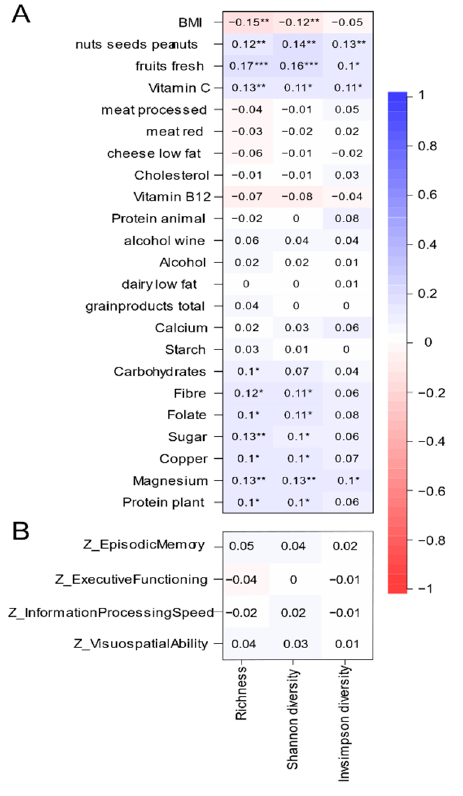
Figure 3. Correlation of alpha-diversity with microbiota covariates ( A ) and cognition variables ( B ). Pearson correlation of significant microbiota covariates were calculated. p values are corrected for multiple testing using the Benjamini–Hochberg procedure. *** q < 0.001, ** q < 0.01 * q < 0.05.